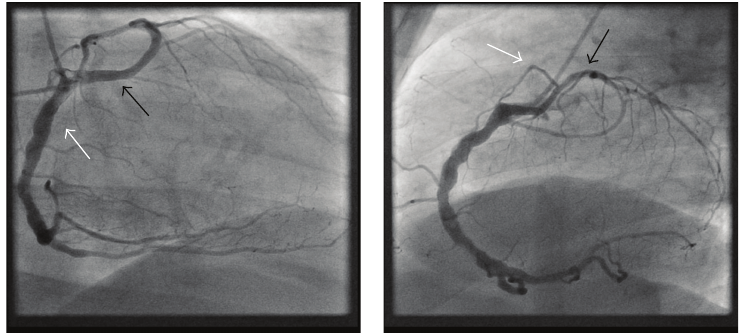
Figure 1: Transseptal course of the right-sided left main coronary artery by CTA and selective coronary angiography.